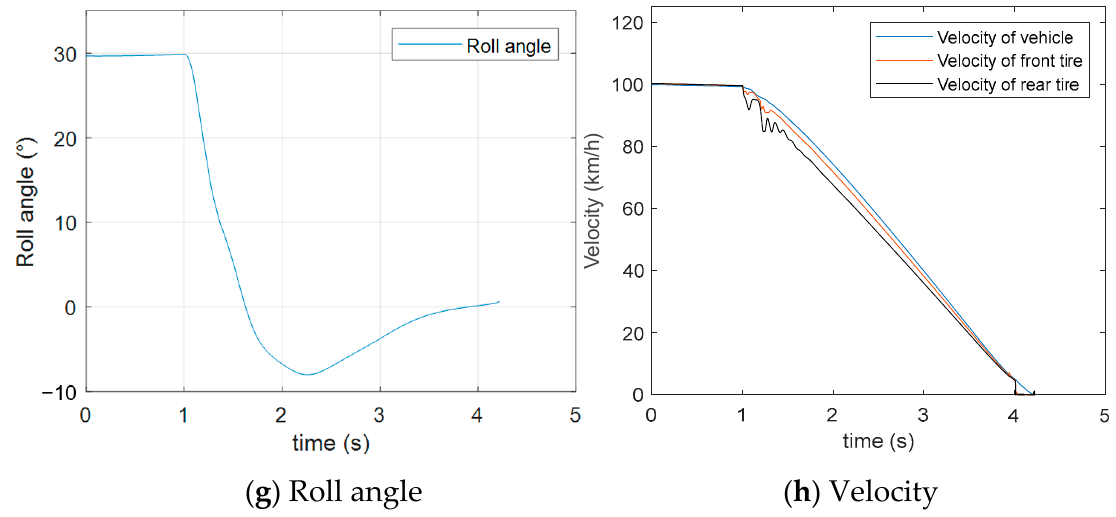
Figure 13. Braking performance for optimal slip ratio input.